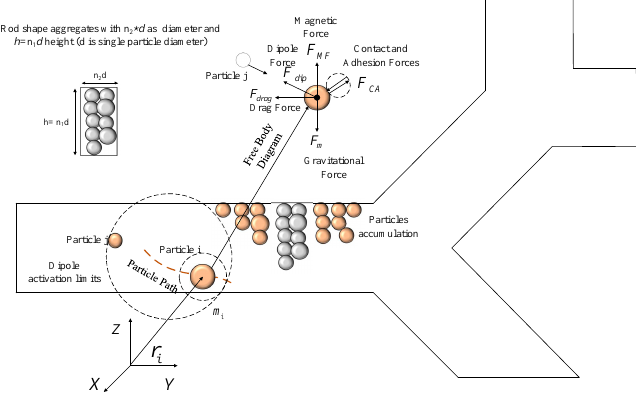
Figure 2. A particle i inside the vessel is considered; the effective forces are shown in the free-body diagram and the geometry of the rod-shape aggregates is